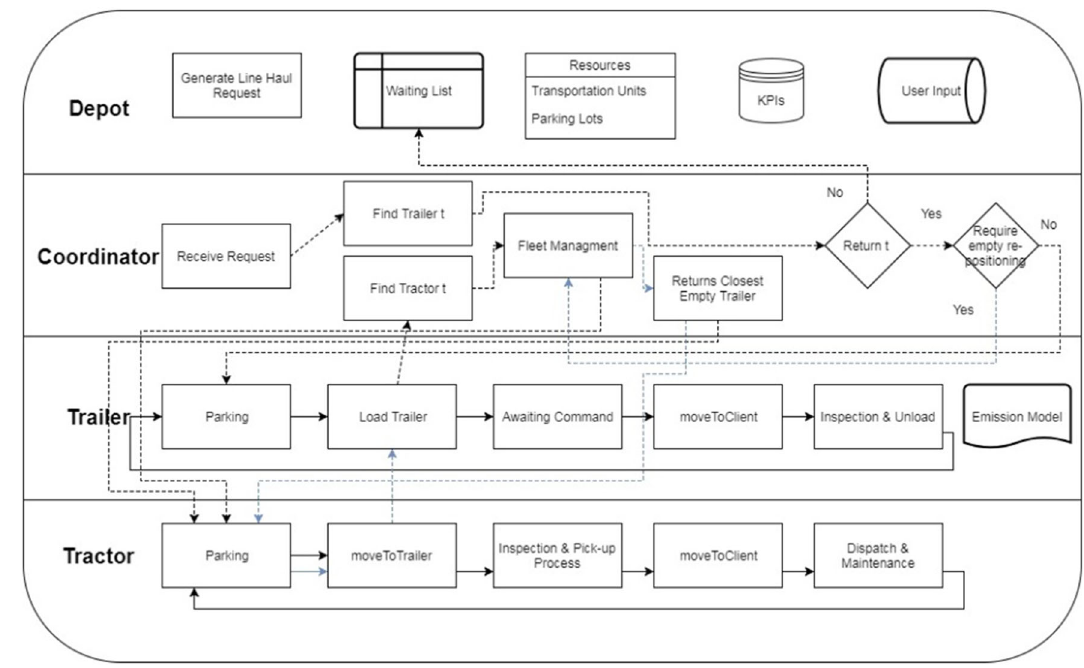
Fig. 2 Schematic of the agent-based simulation